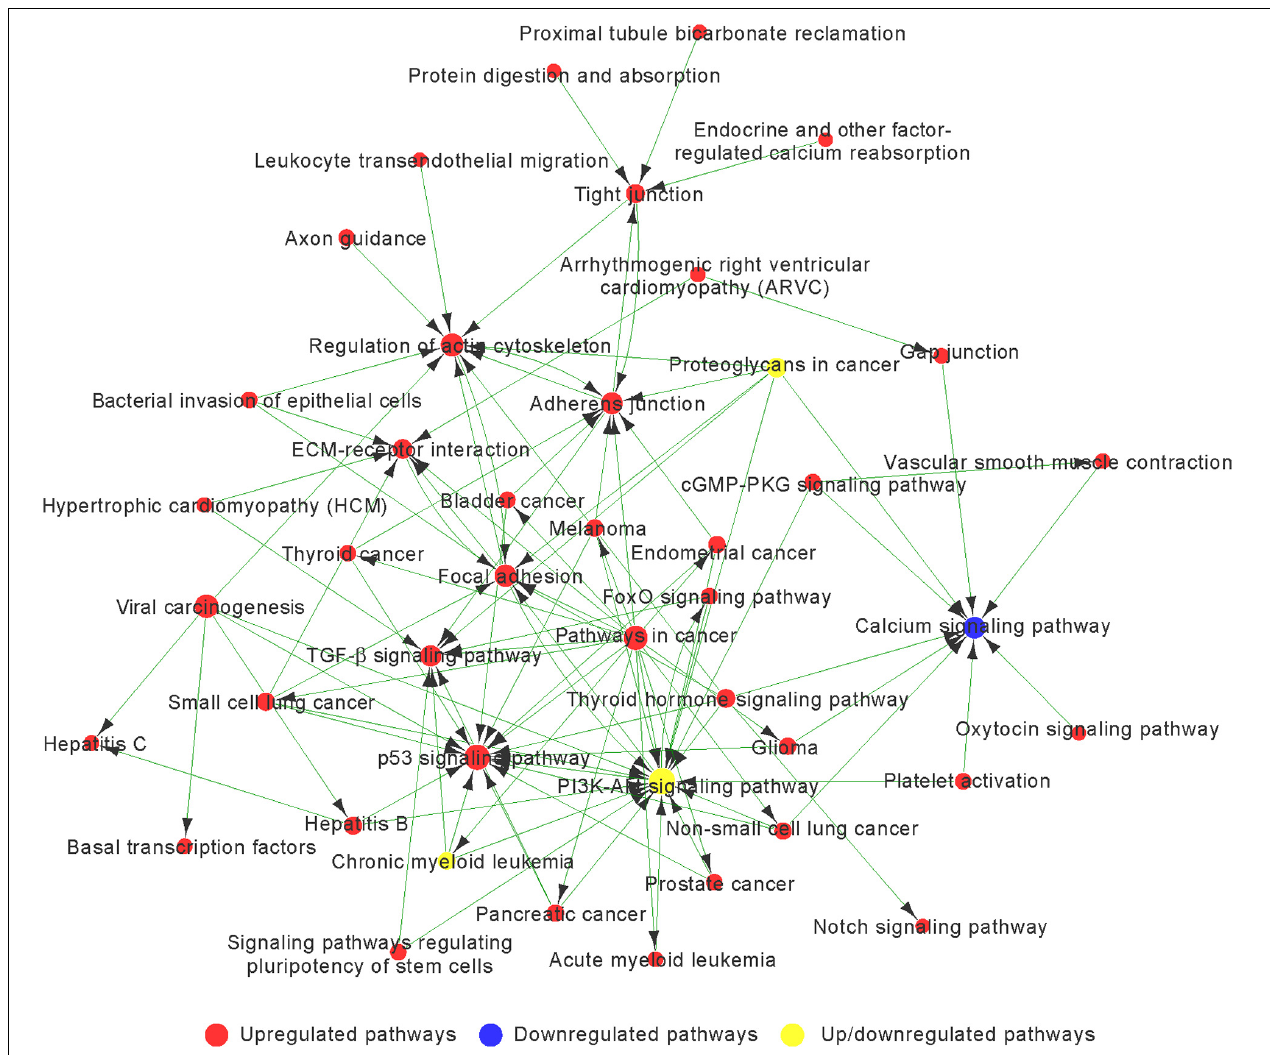
FIGURE 4 | The interaction network of significant pathway (Path-Net) analysis of differentially expressed genes during chondrogenic differentiation. Nods represent different signaling pathways. Red and blue represent upregulated and downregulated pathways, respectively. Yellow represents both upregulated and downregulated pathways. Lines indicate a trigger relationship between significant pathways. The size of circle reflects the number of other pathways interacting with this